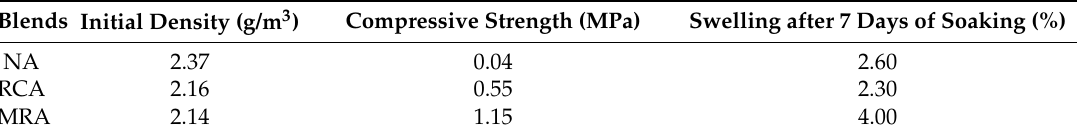
Table 4. Accelerated swelling test for NA, RCA and